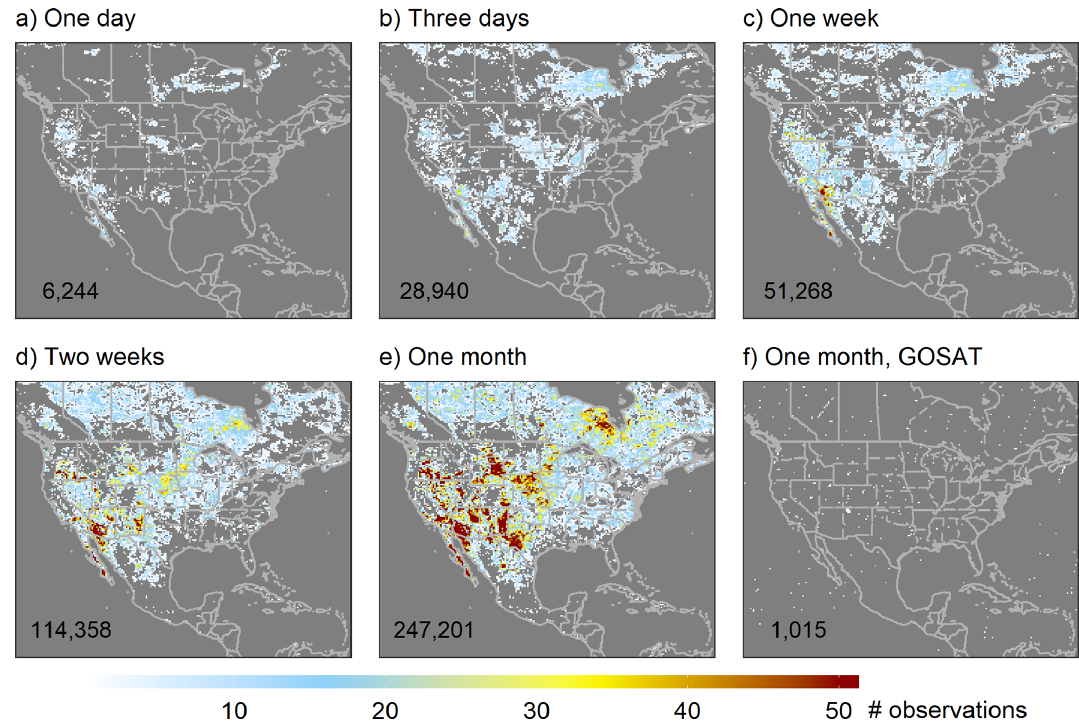
Figure 2. TROPOMI sampling density at 0.25 ◦ × 0.3125 ◦ resolution ( ∼ 25km) for 1d to 1 month observing intervals after filtering for data quality and clouds. GOSAT coverage (with no data filter) is shown for comparison. The total number of observations is labeled in each